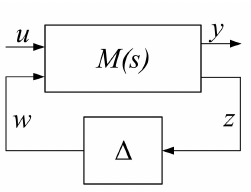
Figure 7. General model of BG-LFT.